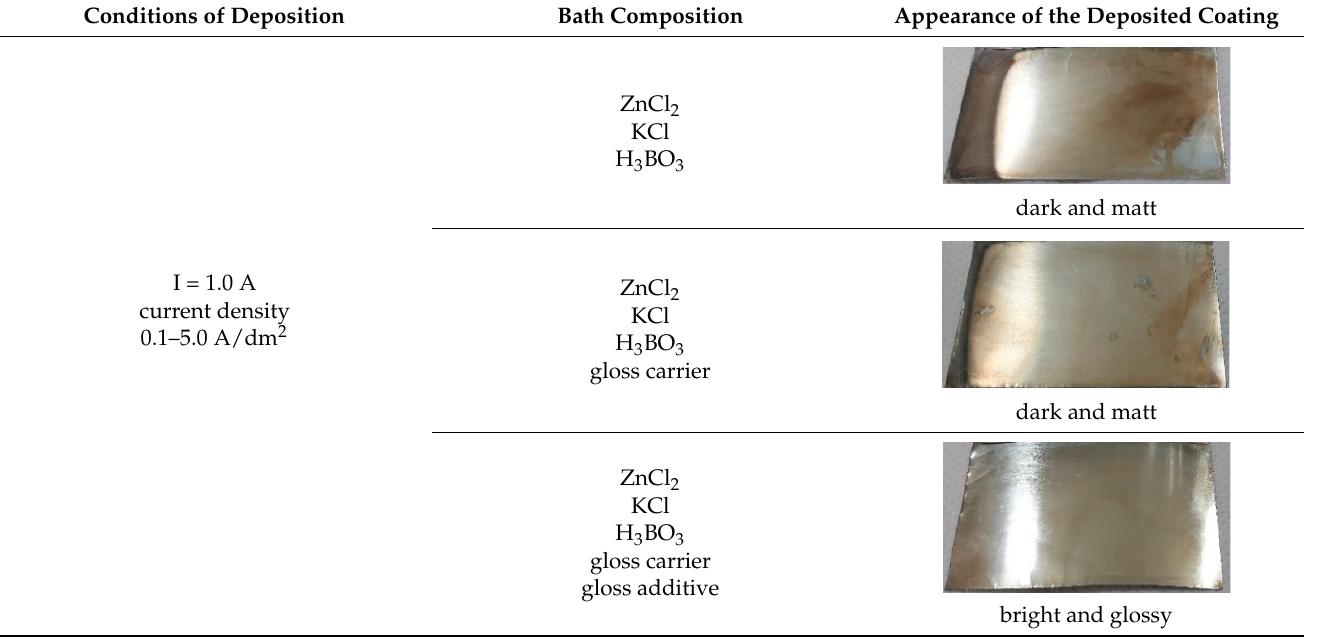
Table 4. Optimization of process conditions and bath composition for zinc coating using Hull cell test.